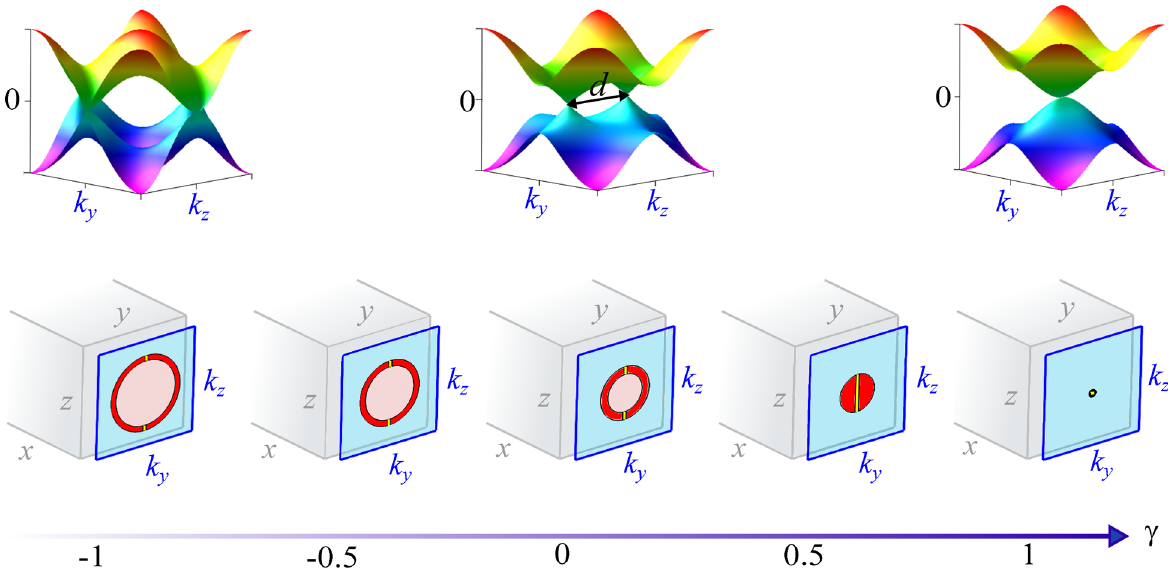
1 (creation of Weyl points) to t y k y from γ Figure 2. Weyl points and surface states with energy ε = ± = − 1 (annihilation of Weyl points) (bottom blue arrow). (top figure) Bulk band energy for γ 1, 0, 1 , γ = = − where d is the distance between the Weyl points. (bottom figure) The gray shape represents the material in real k z ) for x ( y ) open- k z ) ( k x space coordinates x , y , z . Accordingly, there are two momenta space planes ( k y − − boundary conditions, where each plane holds the surface state related to the edge of the material along this open direction. In perspective, to exemplify the x open-boundary conditions case, we depicted the momentum space a real and k y k z . In this momentum space, we have solutions where the surface states only decay with (cid:31) − − = 2 γ < k 2 < 2 ( 1 γ) Eq. (8), solutions where the surface k 2 positive (red region) which is satisfied for 1 z y + − − a ib for a > 0 (pink region), as well as, solutions where the surface states states decay and oscillate with (cid:31) ± − = 0 (yellow stripes). In only oscillate (blue region). We also have decaying zero-energy surface states along k y = 0.5 the pink color region vanishes and we observe surface states that only decay. We note, as special, at γ = 1 that the radius of the circle containing the surface states decreases until becomes a point at the critical γ −→ 1 47,48 point γ =